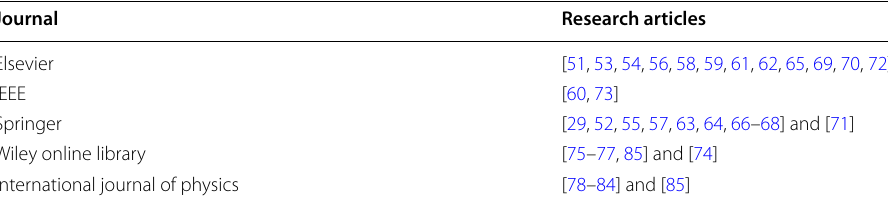
Table 4 Analysis based on journals